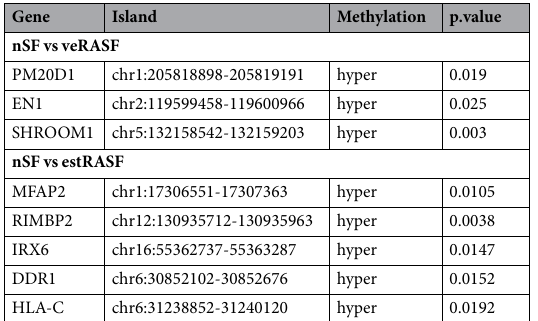
Table 1. Differentially methylated CpG islands within CpG promoters (DMP) with at least 3 differentially methylated CpG sites.